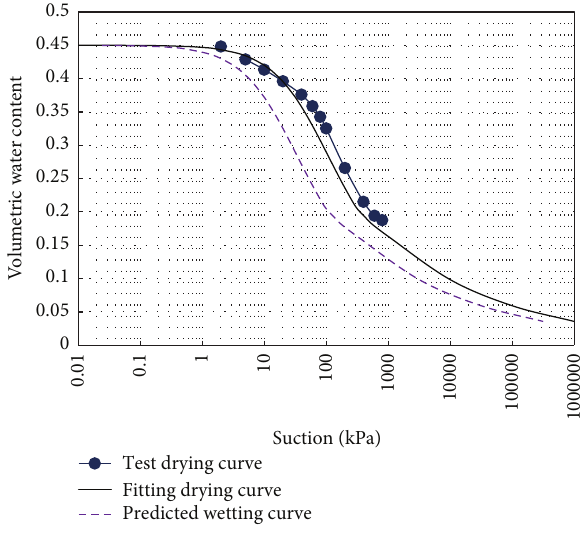
Figure 8: SWCC for